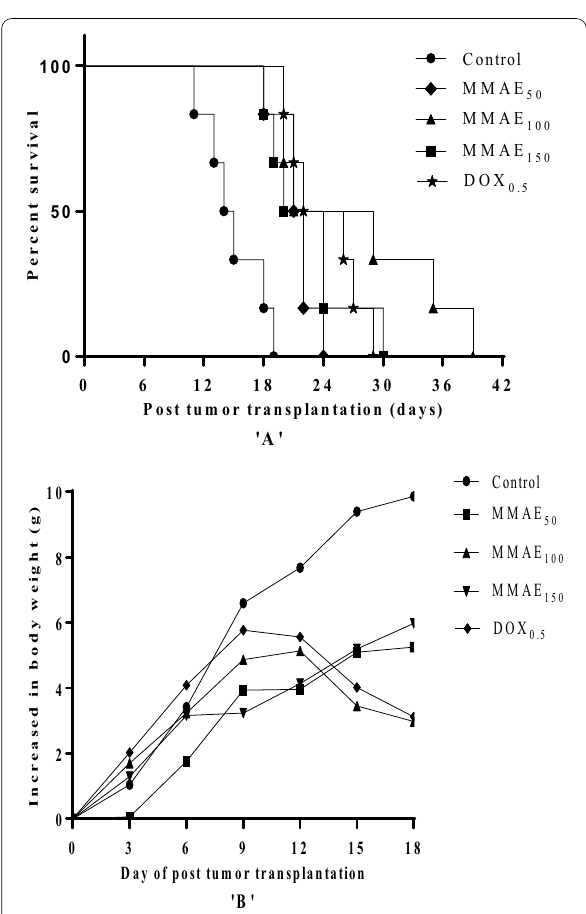
Fig. 1 A Kaplan Meier’s estimate of survival time of DLA bearing mice; B Average increase in body weight of DLA mice treated with different doses of MMAE in three days intervals. Control: DLA bearing mice without treatment; MMAE 50, MMAE 100, MMAE 150 : DLA bearing mice treated with aqueous extract of M. macrophylla at the dose of 50, 100 and 150 mg/kg b.wt, respectively; DOX 0.5 : DLA bearing mice treated with doxorubicin (0.5